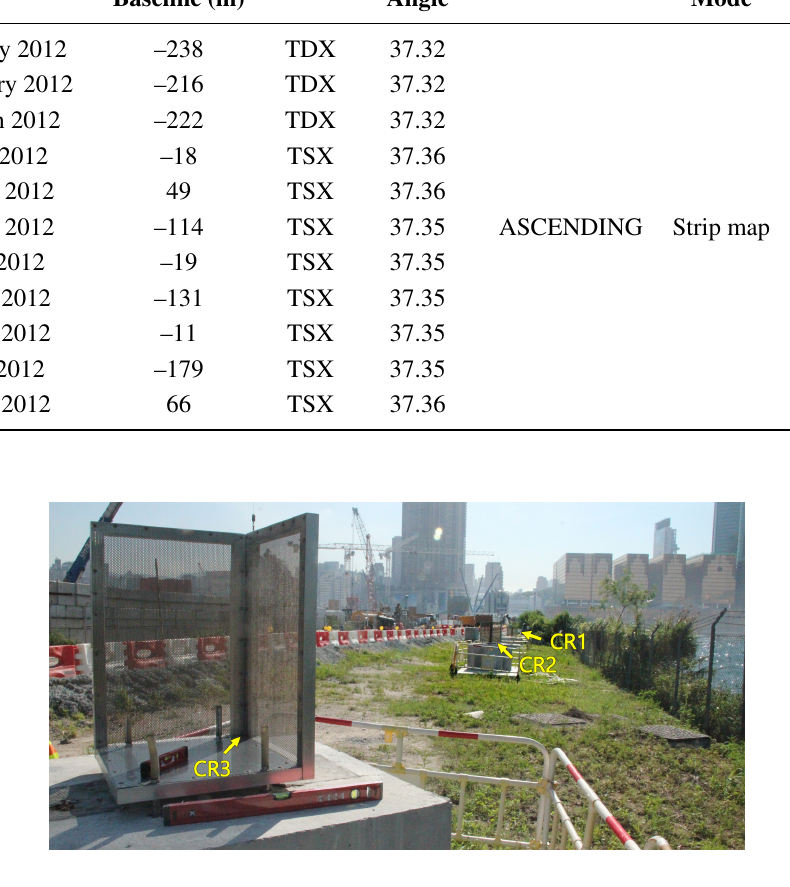
Figure 3. Corner reflectors installed on site for the validation